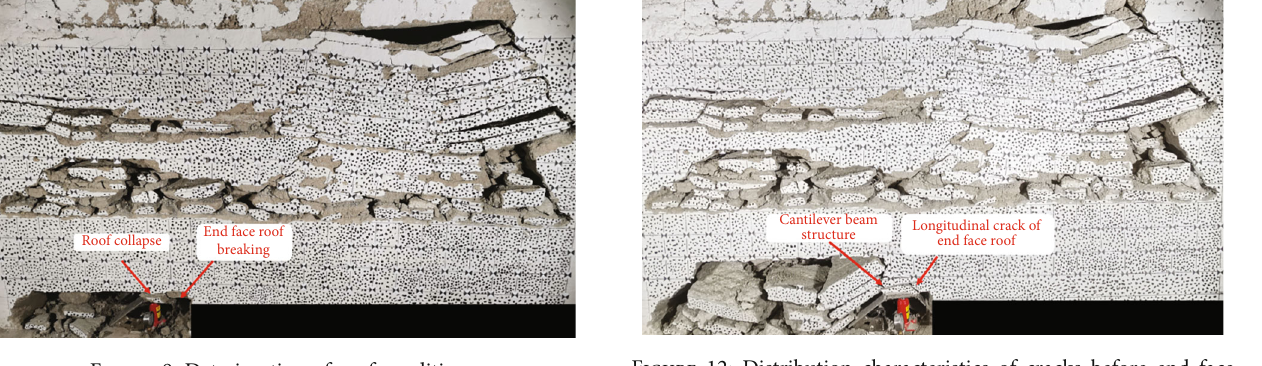
Figure 9: Deterioration of roof conditions.